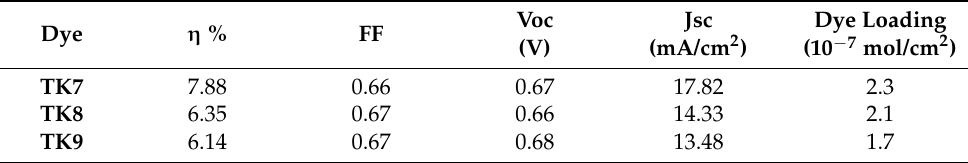
Table 10. Photovoltaic parameters of TK7 , TK8 and TK9 in DSSC devices. Dye η % FF